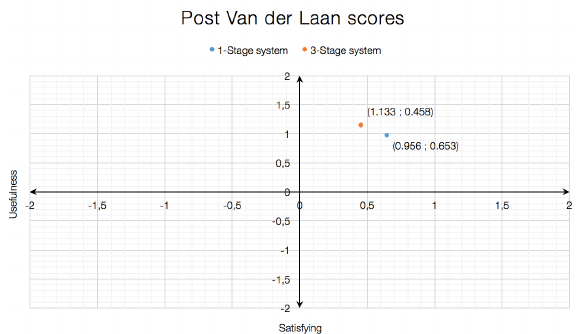
Figure 8. Post Van der Laan